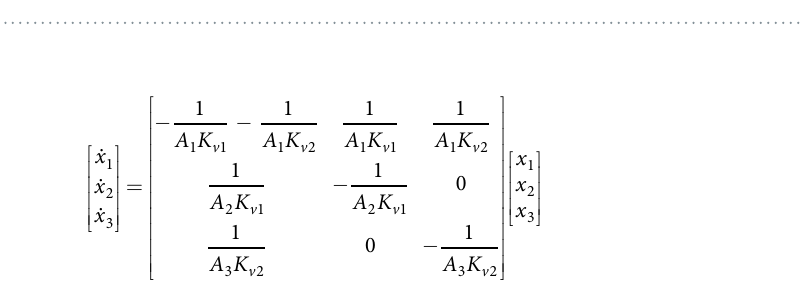
Figure 6. The examined four types of water-tank network models with associated inputs ( u ) and outputs ( y ). ( a ) Physical connection between state variables. ( b ) Self-influencing represents integrating node dynamics. ( c ) Interaction represents balanced dynamics (material balance). ( d ) Detailed model of the system. Already this small example clearly shows how connection types change the number and location of the driver and sensor nodes. The driver and sensor nodes were determined by the path-finding method introduced in section II of the Supplementary